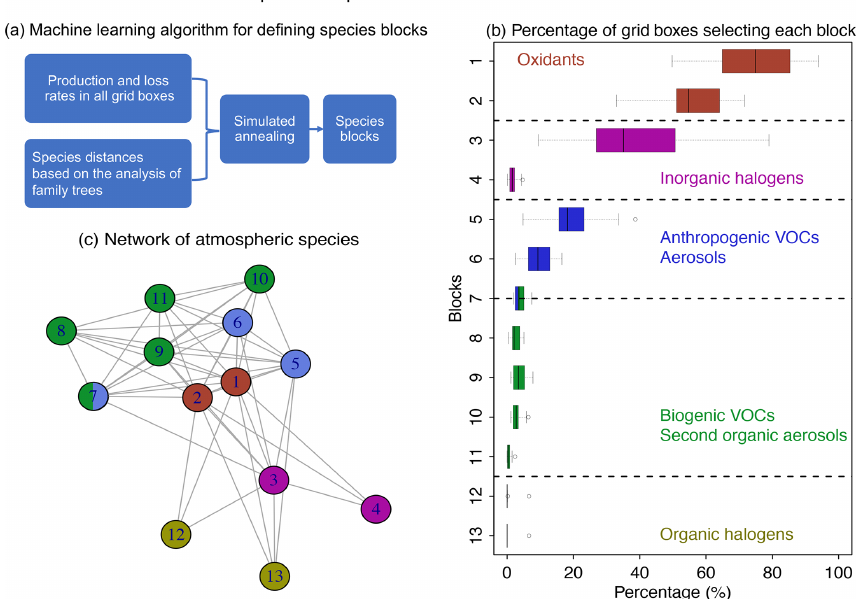
Figure 4. Optimized species blocks and their network in the full chemical mechanism. Panel (a) describes the machine learning method to solve for the species blocks. See more details in Sect. 2. Panel (b) shows the 13 species blocks and the percentage of grid boxes that treat the blocks in their submechanisms. The list of species in each block is given in Table 1. Block 7 includes both anthropogenic and biogenic VOCs. The left and right of each box are the 25th and 75th percentile, and the centerline is the 50th percentile. We use a threshold of 500 moleculescm − 3 s − 1 to partition fast and slow species. Panel (c) is the network of species blocks. A connection means that at least two species from these two blocks appear in the same reaction. The distance between the two blocks is proportional to the block distance as defined by Eq. (3).